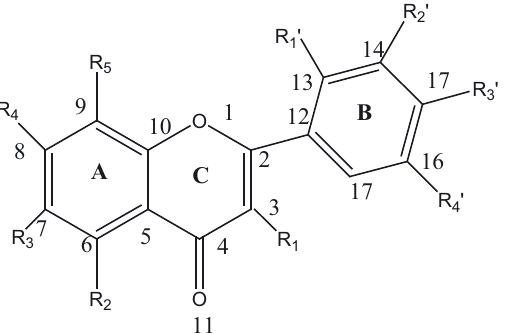
Figure 1. General structure of flavonoids: the common atoms have been numbered